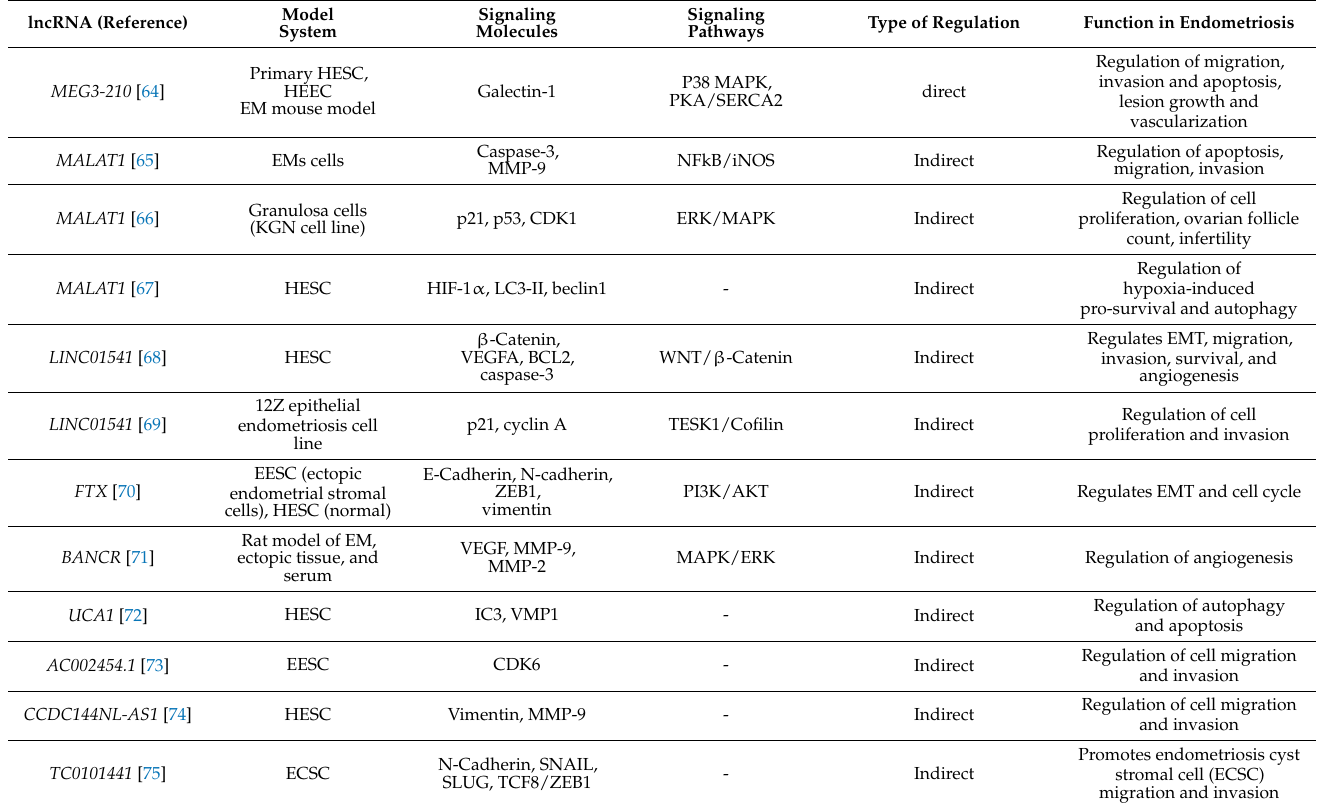
Table 3. Mechanisms of cell signaling regulation via lncRNAs in